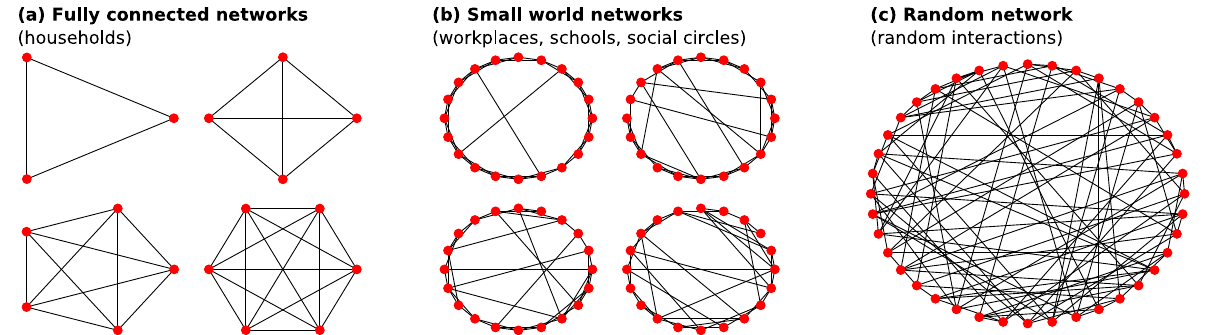
Fig. 8 Example interaction networks. Examples of fully connected ( a ), Watts – Strogatz small-world ( b ), and random ( c ) networks that de fi ne interactions among synthetic agents in households ( a ), workplaces, schools, social circles ( b ), and random ( c )